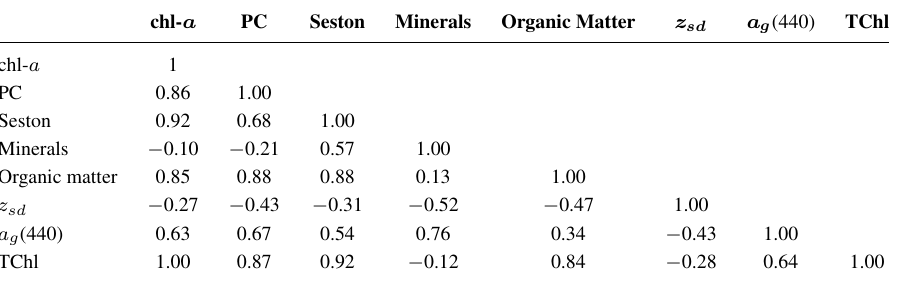
Pearson correlation coefficients for entire dataset. The variables